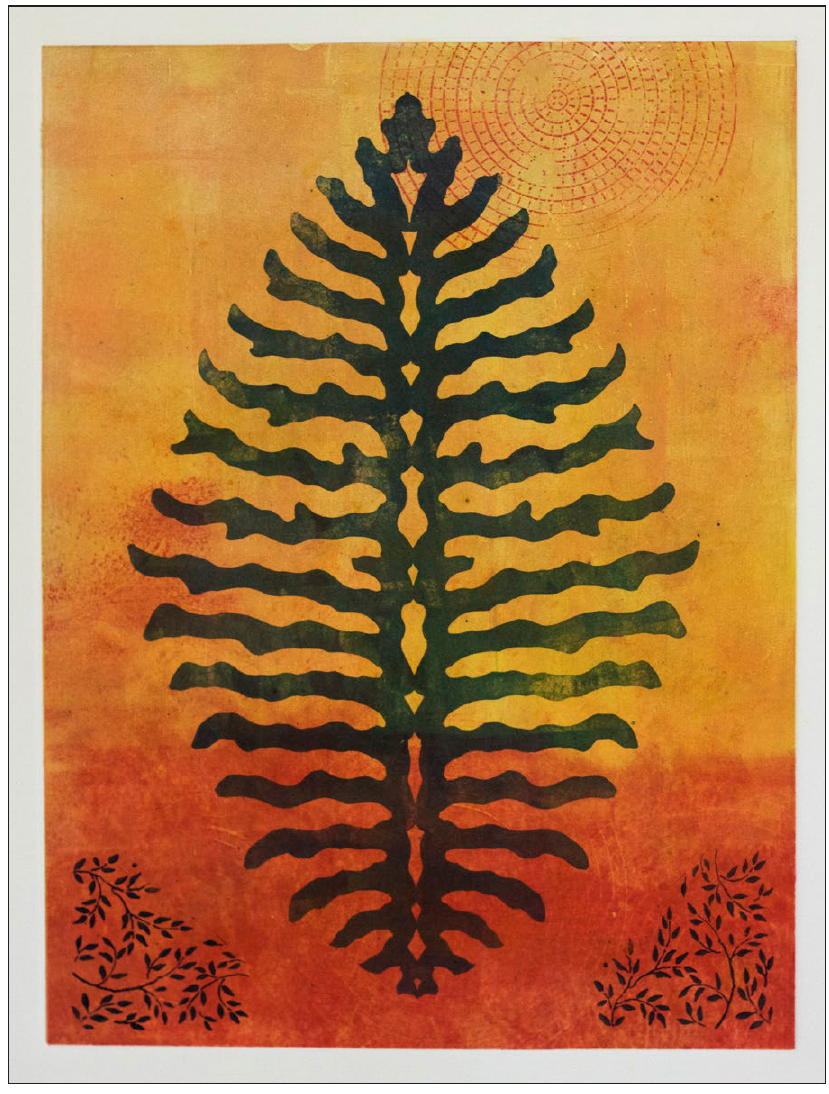
Figure 1: Rachel Epp Buller, Arbor 13, 2015, monotype, 12 × 9 inches. Berlin. She is a board member of the National Women’s Caucus for Art (US), a Fulbright Scholar, a regional coordinator of The Feminist Art Project, and cur- rent Associate Professor of Visual Arts and Design at Bethel College (US). * *